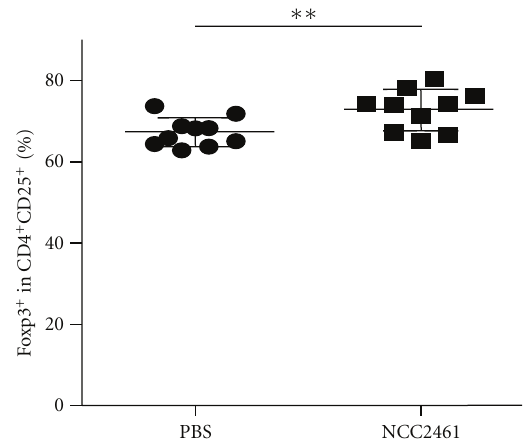
Figure 4: Percentage of FoxP3 positive cells in the CD4 + CD25 + T cell population in the lung of mice treated intranasally with PBS or with NCC2461. One representative experiment out of two indepen- dent experiments. ∗∗ P < 0 .